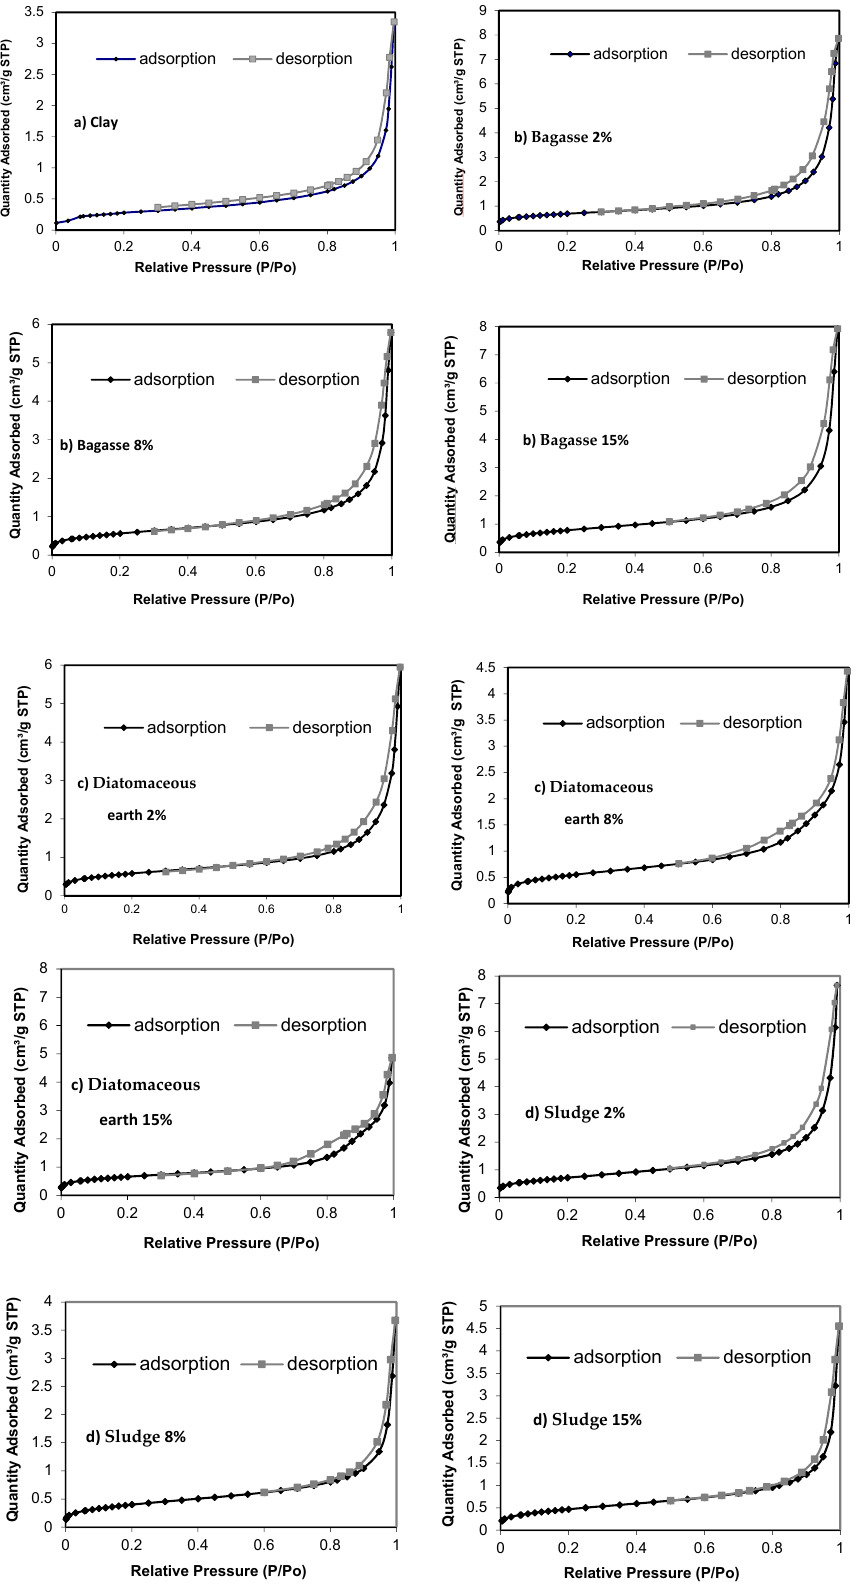
Figure 5. Adsorption Isotherms, N 2 77 K: ( a ) Clay; ( b ) Bagasse; ( c ) Diatomaceous earth; and ( d ) Sludge (950 °C).